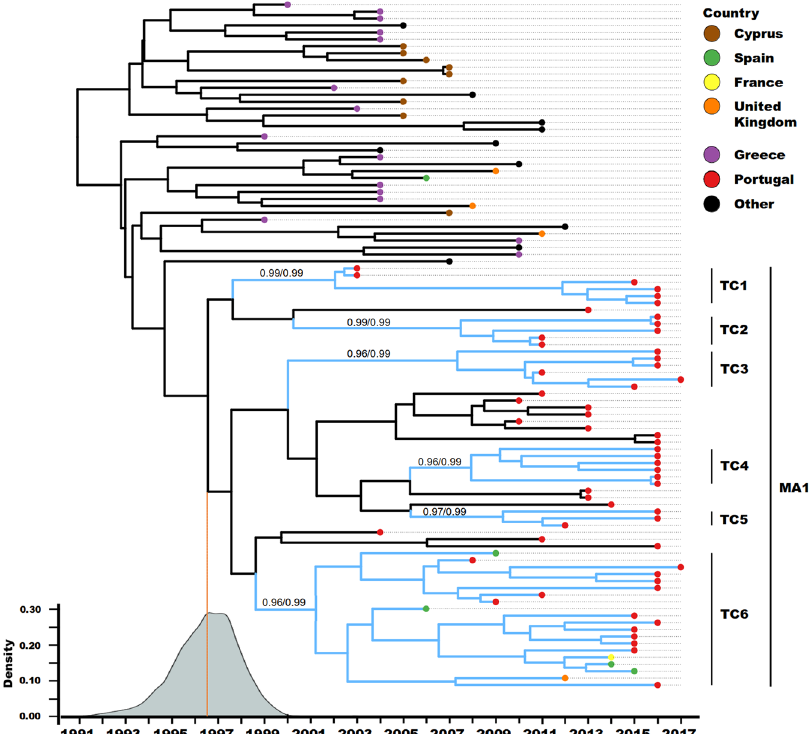
Figure 2. Evolution of the study sub-subtype A1 transmission chain through its most recent history in several European countries. Maximum clade credibility tree summarised from the output trees from the BEAST analyses (n = 99). The tip point colours represent the country where the samples were collected. The blue branch lines indicate that the respective HIV-1 sequence belong to a transmission cluster. The vertical black bars demonstrate the taxa included in each transmission cluster and the main A1 clade (MA1). The aLRT SH-like branch support and posterior probability (pp) of each of the transmission clusters is displayed (aLRT/pp). The density plot in the bottom left refers to the time of the most recent common ancestor of the MA1. The country of sampling of the taxa labelled as others is: USA (3); Belgium (3); Sweden (1); Australia (1); The Netherlands (1), and Kuwait